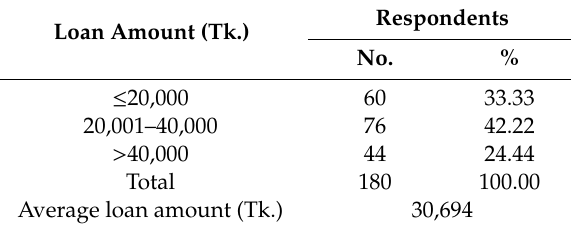
Table 4. The amount of microcredit received by borrowers.